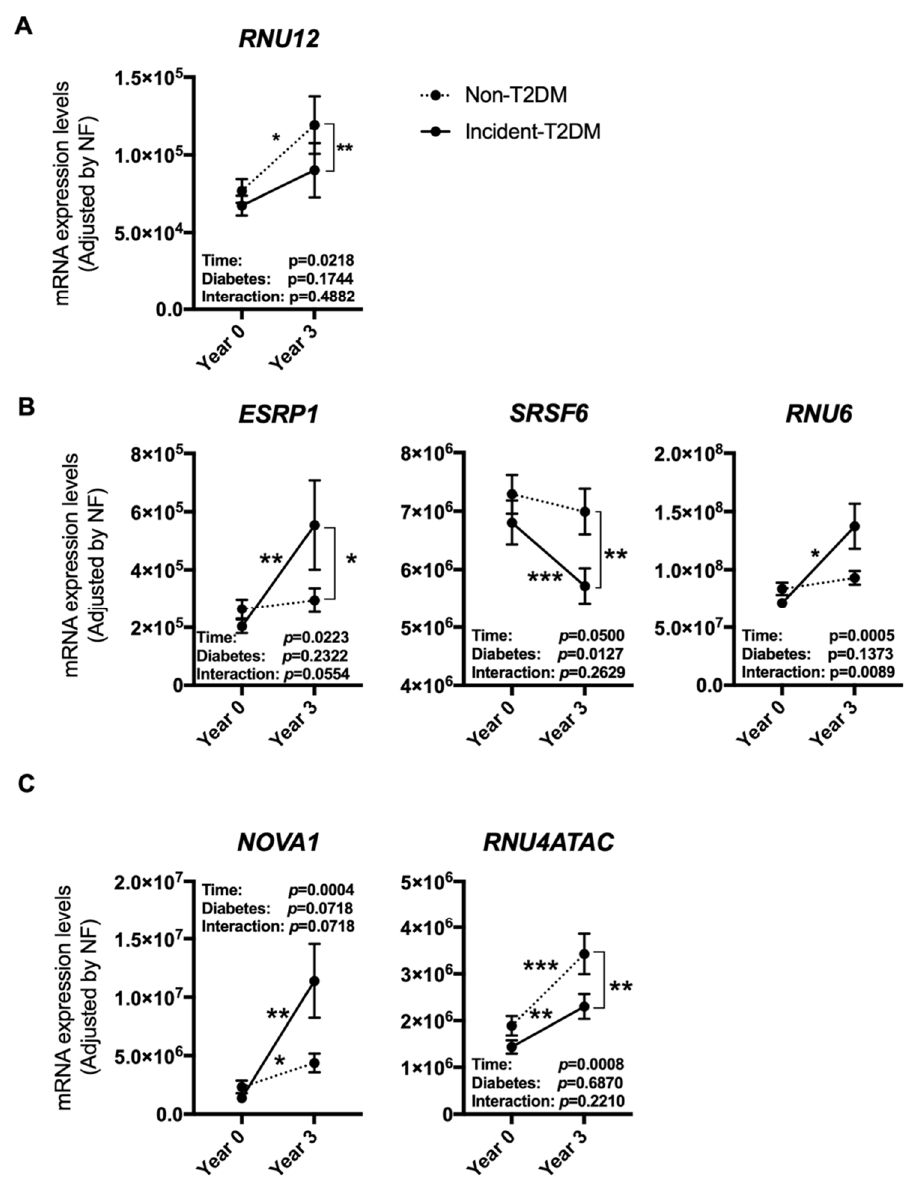
Figure 3. PBMCs expression pattern of specific splicing machinery components after three years of follow-up in non-T2DM and incident-T2DM subjects. Splicing machinery components altered in non-T2DM subjects ( A ), incident-T2DM subjects ( B ) or both ( C ). mRNA expression levels [adjusted by a normalization factor (NF) calculated from the expression level of GAPDH and ACTB] of specific spliceosome components and splicing factors in the PBMCs from all the participants included in the study. Values represent the mean ± SEM. Asterisks indicate values that significantly di ff er from non-T2DM subjects ( t -test: *, p < 0.05; **, p < 0.01; ***, p < 0.001).